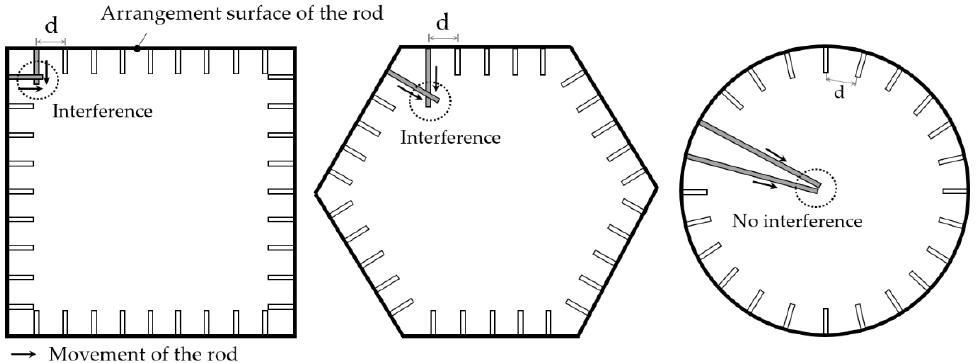
Figure 7. Interference according to the arrangement of the rod.